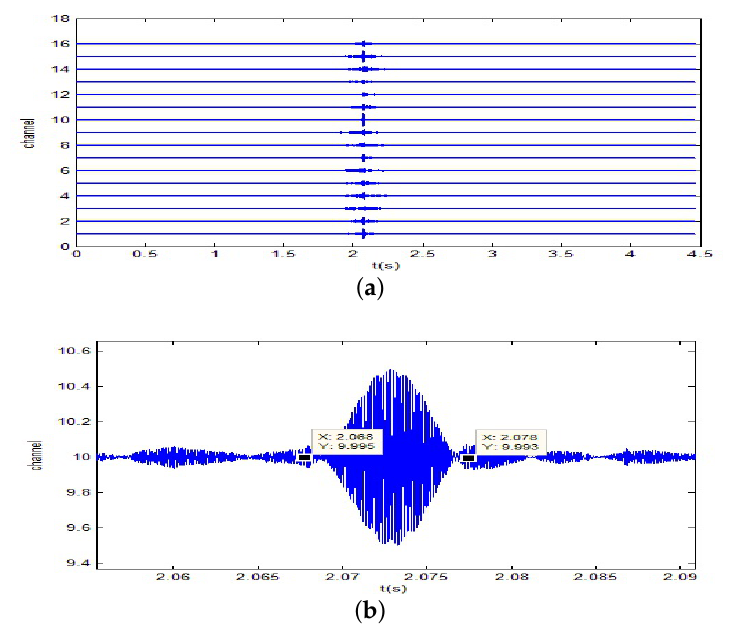
Figure 10. Time reversal-focusing with PCW signal at 7 kHz: ( a ) the time-reversed signals received by the 16-element vertical array; ( b ) local amplification of the signal of the 10th channel.